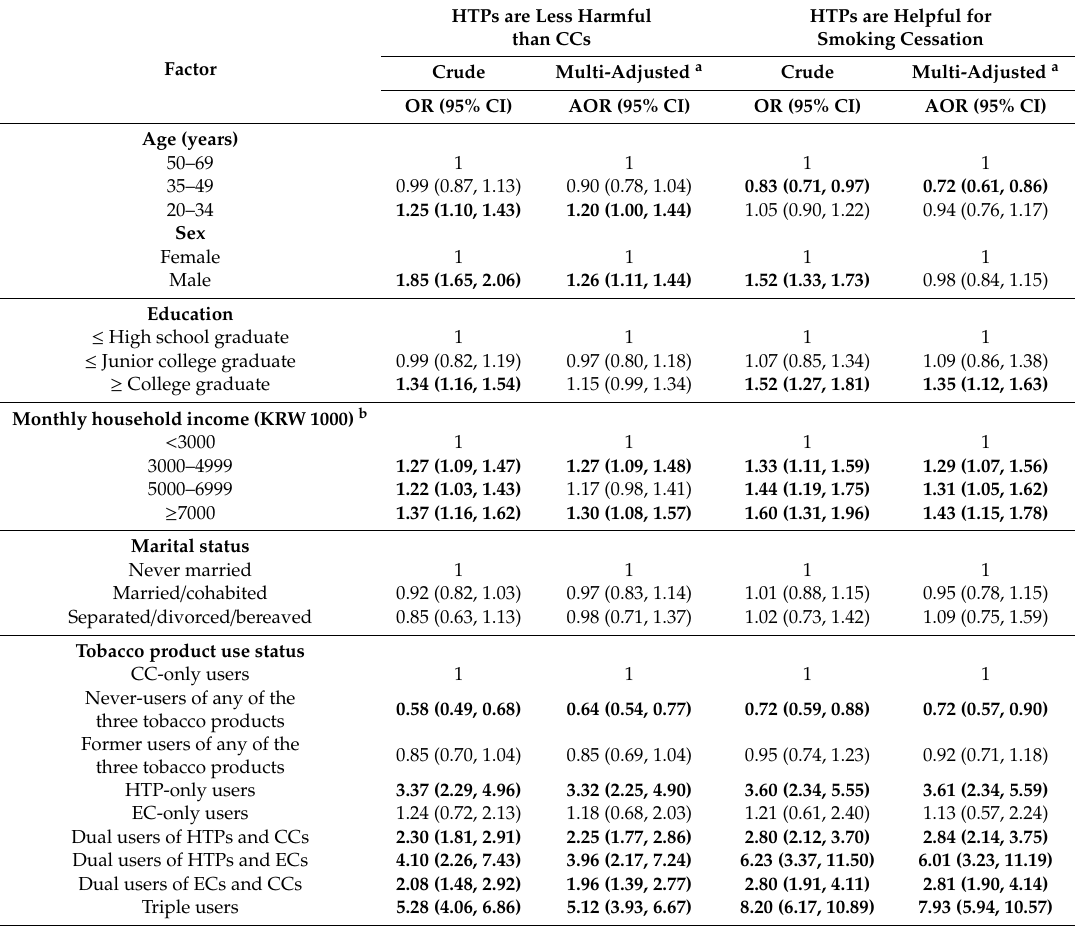
Table 2. Comparison of beliefs about the harmfulness of HTPs compared with CCs, and the perceived e ff ectiveness of HTPs for smoking cessation ( n =